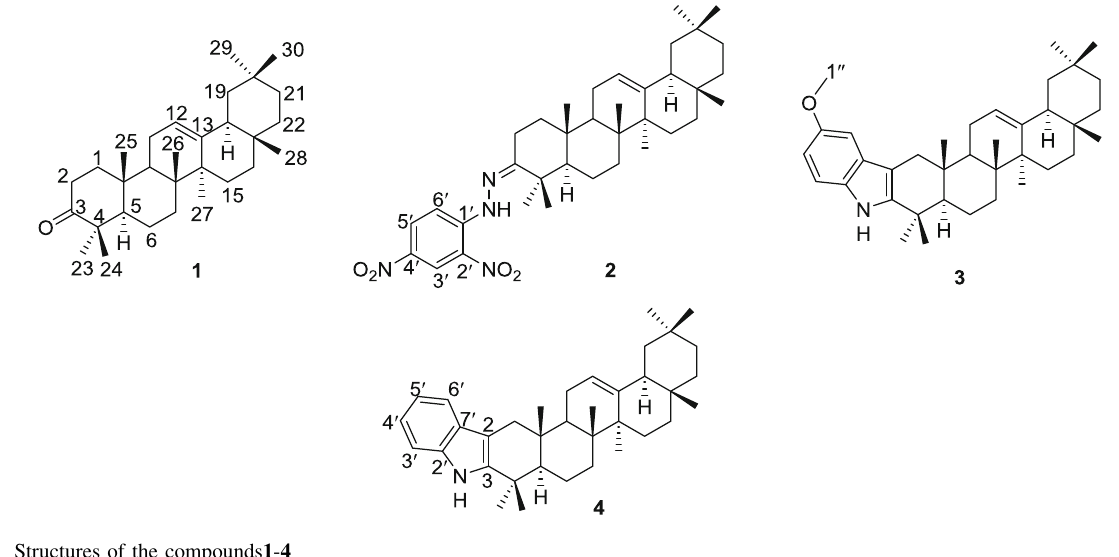
Fig. 1 Structures of the compounds 1 - 4